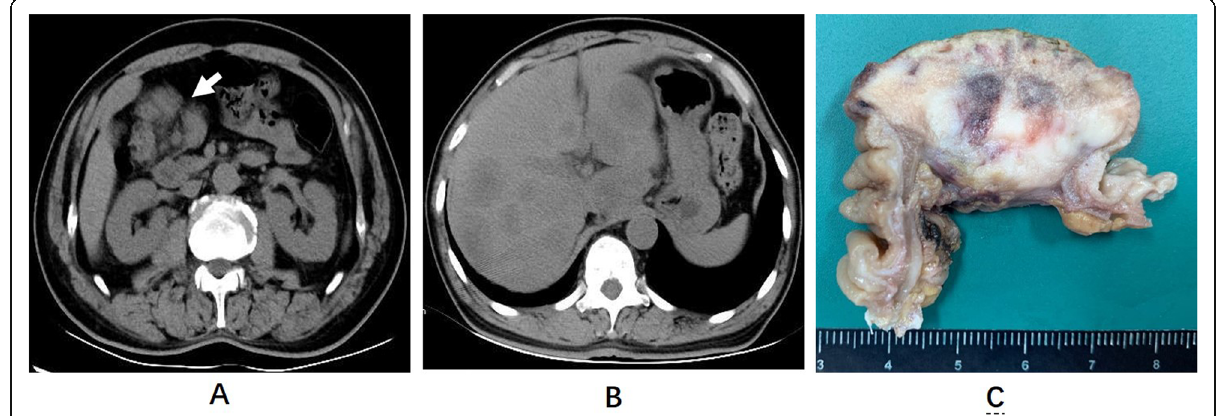
Fig. 1 Axial CT scan at the level of the kidneys ( a ) and liver ( b ) demonstrates a mass (white arrow) within the hepatic flexure of the colon and multiple liver masses, respectively. The cut surface ( c ) shows the tumor has penetrated through the muscle wall of the colon, exhibiting